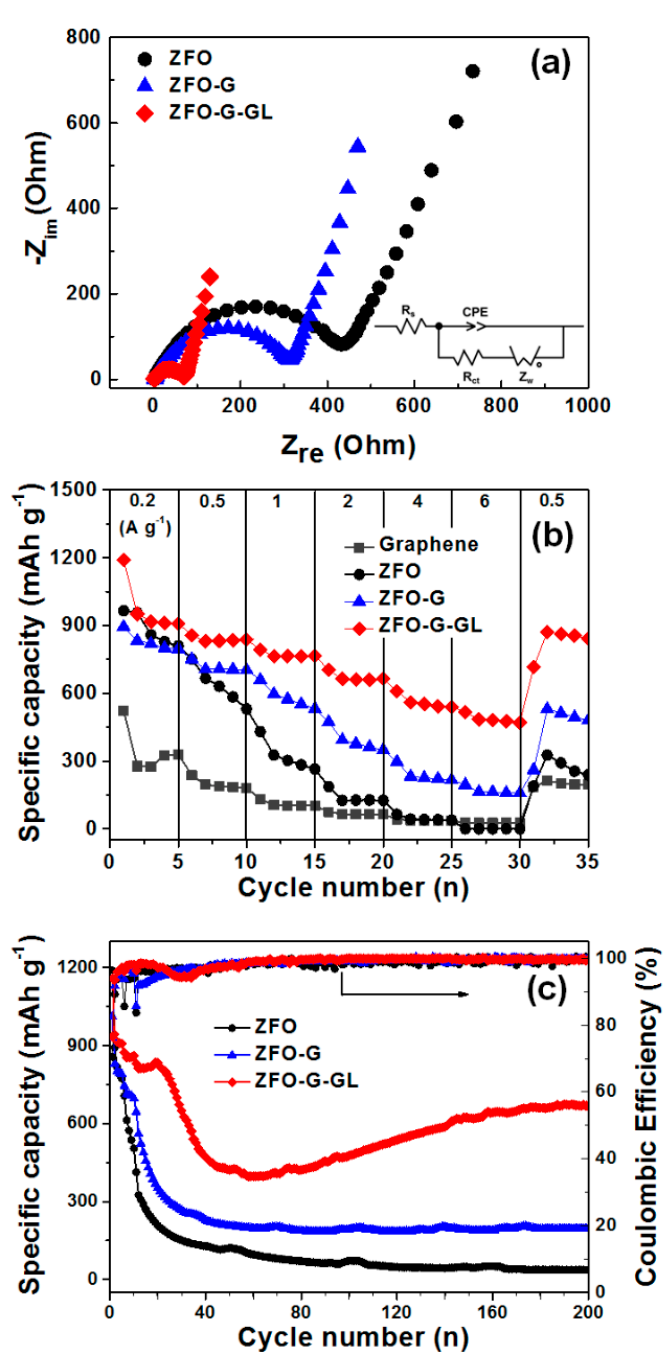
Figure 8. ( a ) Electrochemical impedance spectra (inset) equivalent circuit; ( b ) specific discharge capacities at various current density (0.2–6 A g − 1 ); and ( c ) cycling performances and coulombic efficiency at a rate of 1 A g − 1 of ZFO, ZFO–G, ZFO–G–GL, and graphene (only in (b)).